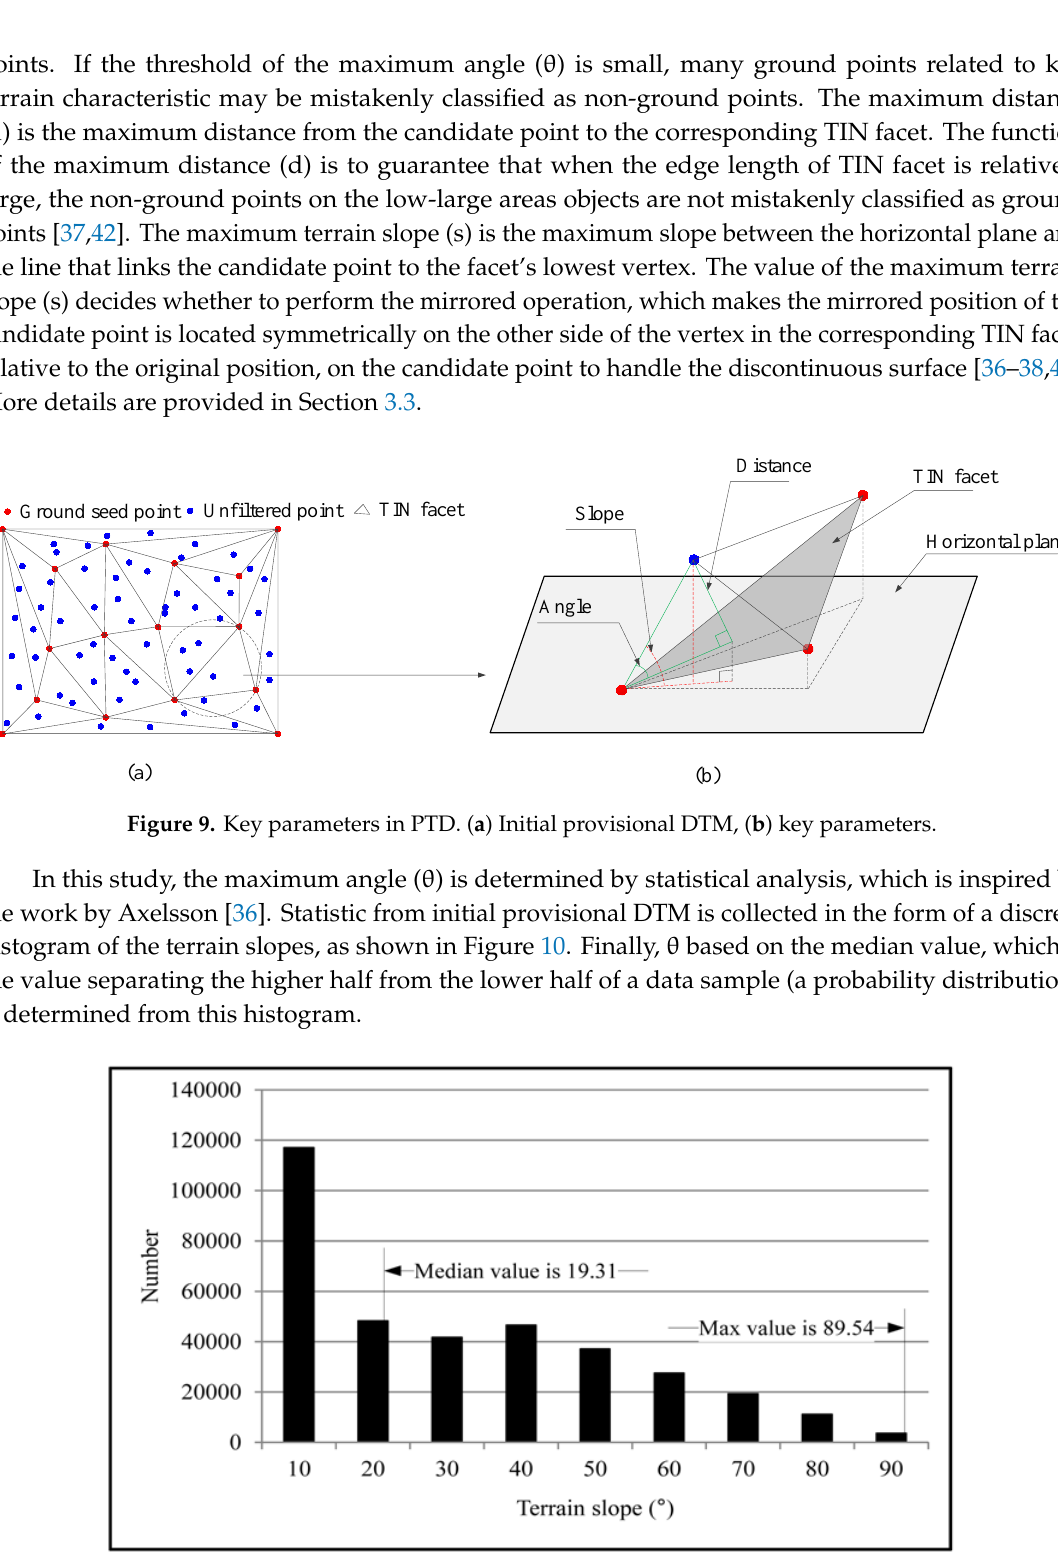
Figure 10. The discrete histogram of terrain slope.